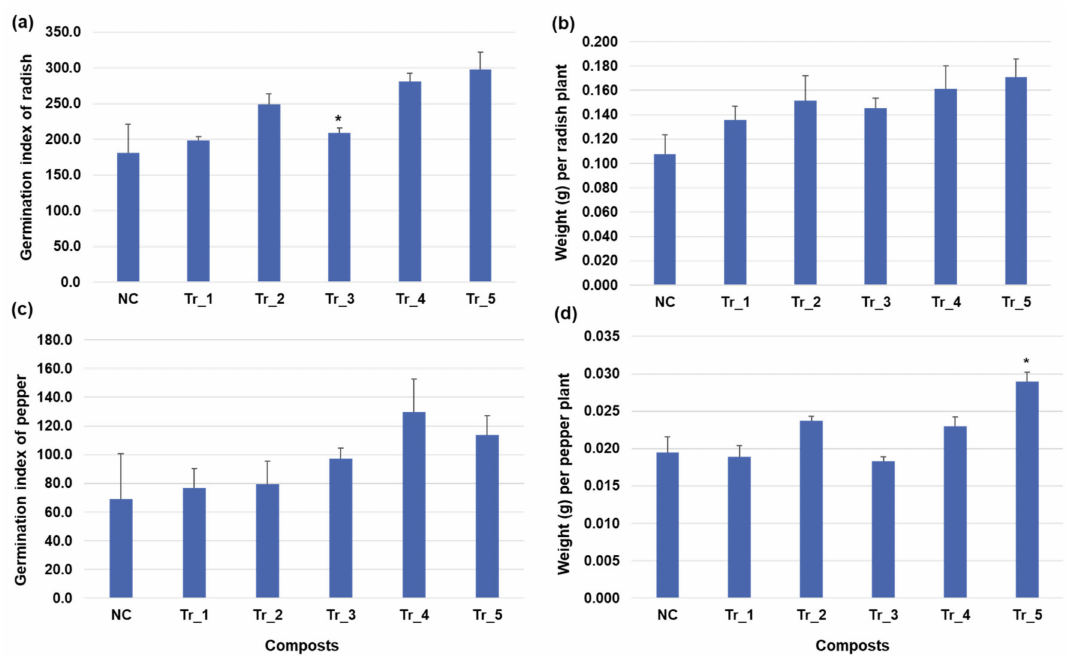
Figure 5. Effects of the functional composts on the growth of radish plants ( a , b ) and pepper plants ( c , d ). NC, Tr_2, and Tr_4 were the controls for Tr_1, Tr_3, and Tr_5, respectively; * indicates the significance of the treatment comparing with the control; *— p <